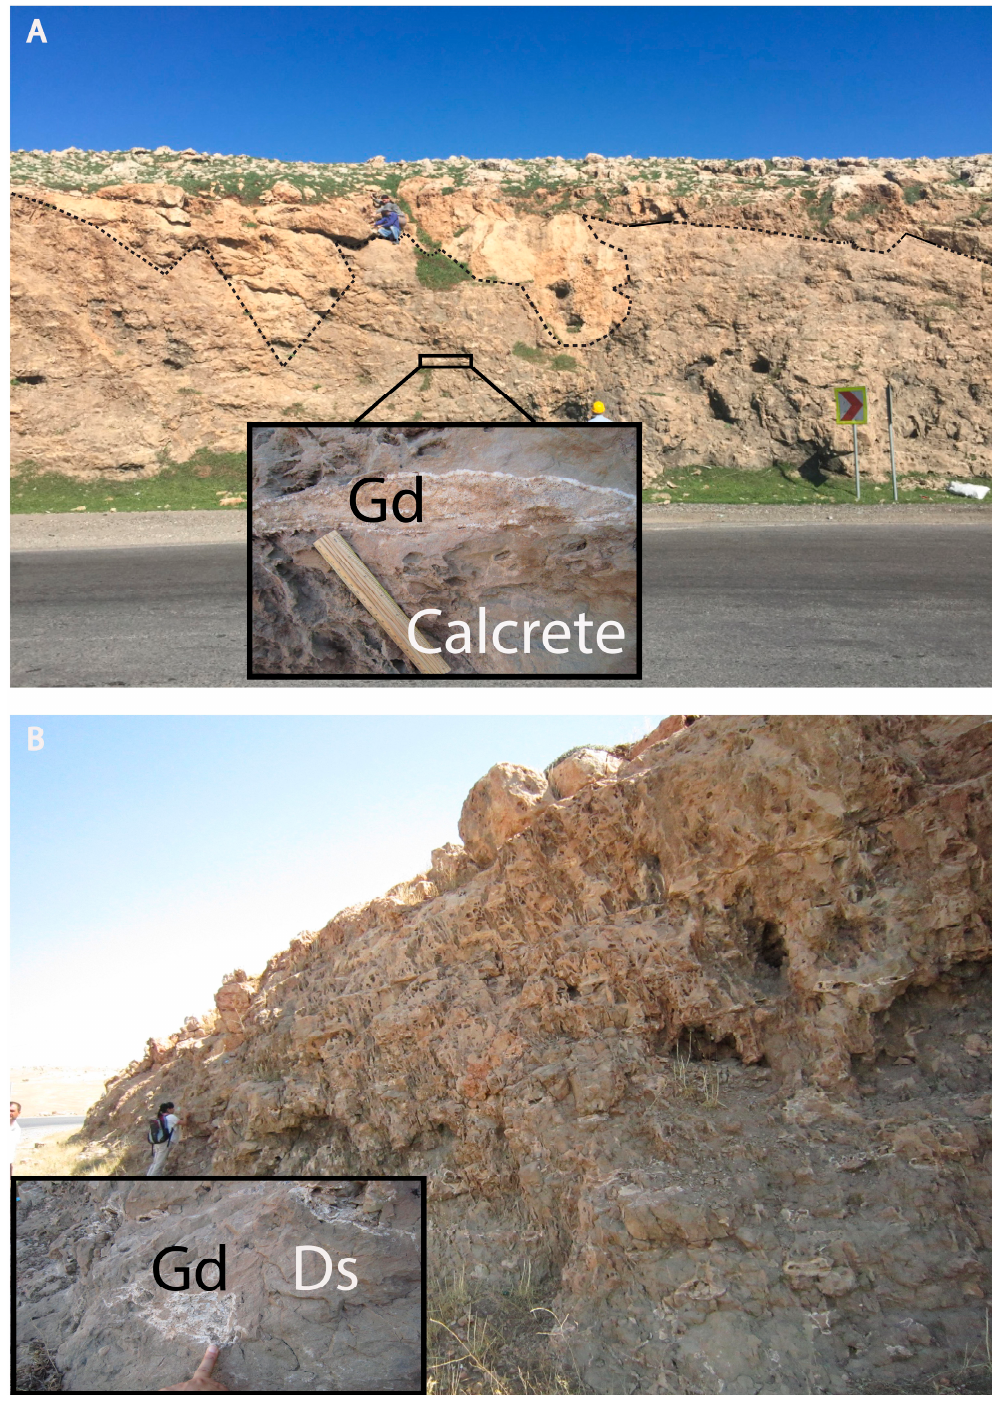
Figure 4. Spelek section. Photographs with inserts showing ( A ) calcrete profile displaying pronounced geodes (Gd) filled by saddle dolomite and blocky calcite arranged in multiple levels parallel to stratification, and reflecting the original bedding planes. The emplacement of the geodes (Gd) is interrupted by a yellowish facies in the Bekhme carbonates related to incised channel deposits cutting the original bedding planes (see the dashed line). Spelek section. The inserts show a typical single large geode with quasi-horizontal lower boundary tracing the original horizontal bedding. ( B ) Calcretization of the host limestone and matrix dolomite. Saddle dolomite and blocky calcite are mostly pronounced in the lower part of the outcrop exposing Bekhme Formation (Fm), consisting of saccharoidal dolomite (Ds).